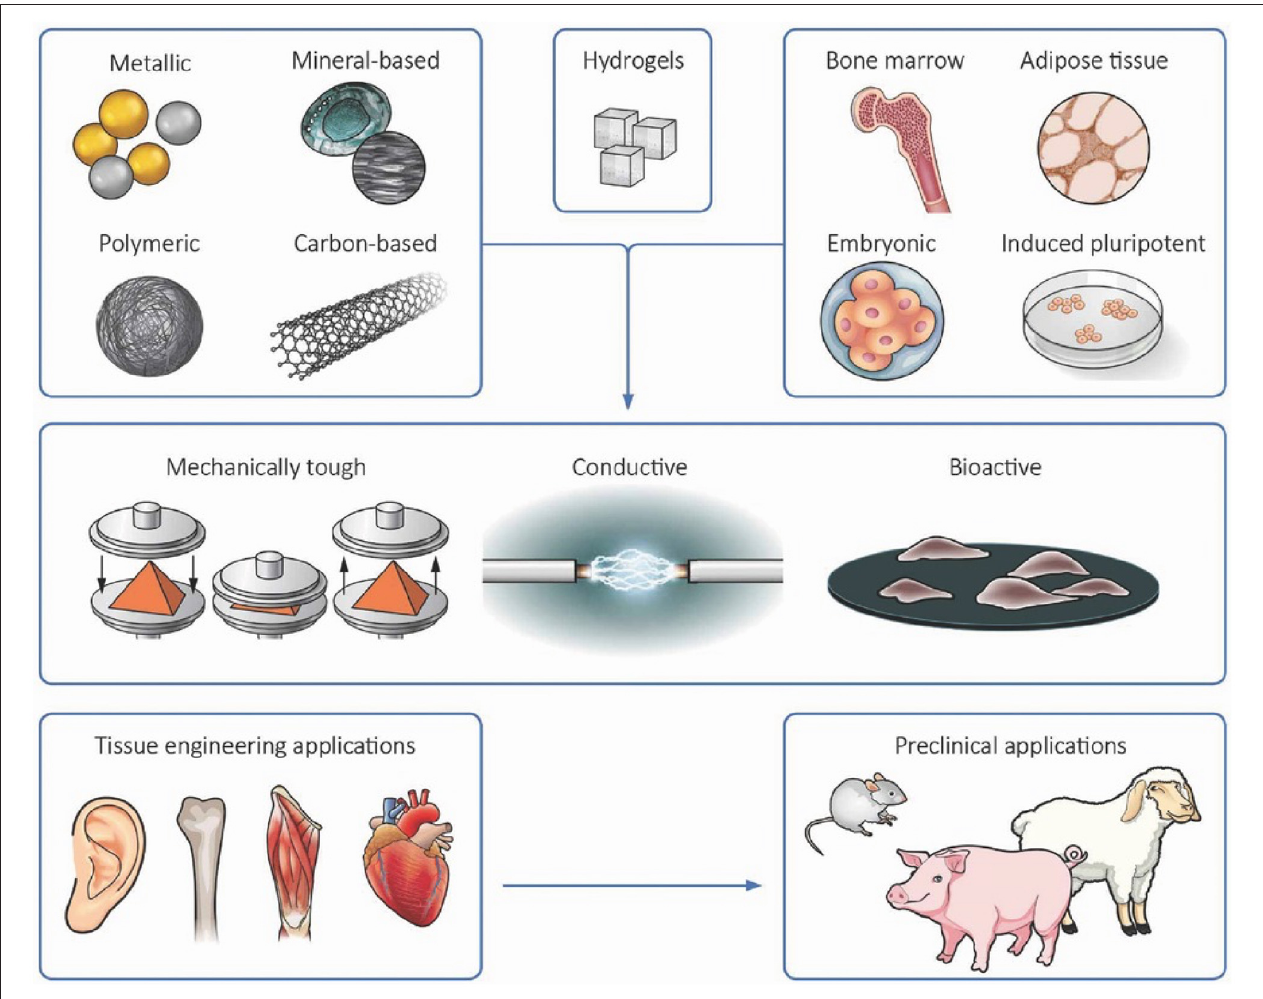
FIGURE 3 | Incorporation of nanomaterials into cell-laden hydrogels presents a versatile strategy for engineering 3D tissue-like constructs with enhanced functionalities including increased bioactivity, electrical conductivity, and mechanical strength. Reproduced with permission from WILEY-VCH ( Mehrali et al.,